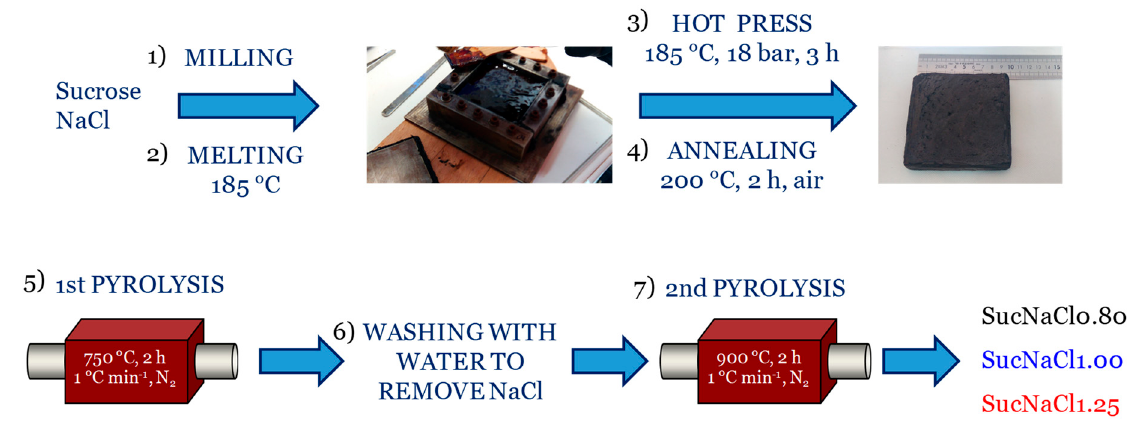
Figure 1. Scheme of the synthetic pathway for preparing sucrose-based monoliths, SucNaClX, where X stands for the sucrose to NaCl weight ratio.